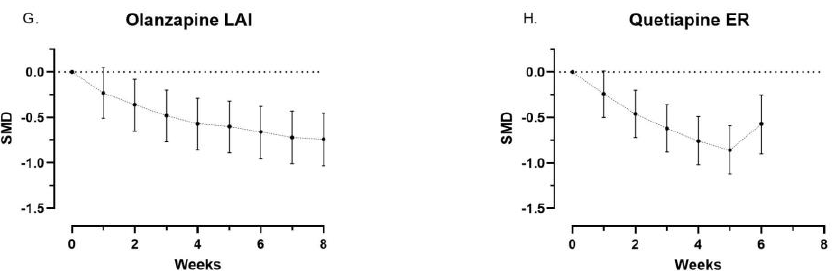
Figure 3. ( A – H ) Illustrates the standardized mean difference (SMD) in the changes in symptom score from baseline to follow-up between intervention and placebo (dots) with 95% confidence intervals (bars). The data also emerges from Table 1 and the Forest plots in the supplemental data file. [ER = extended-release, LAI = long-acting injectable, TDD = transdermal drug delivery].